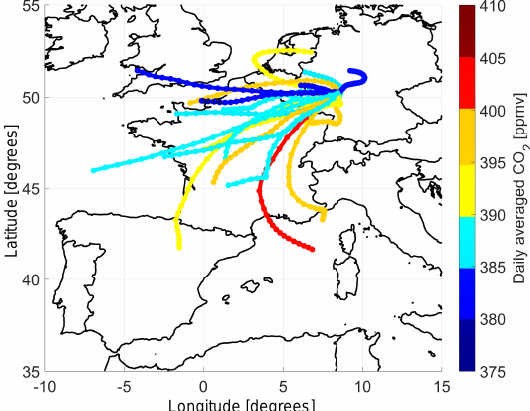
Figure 2. Daily averaged CO 2 observations and the associated stan- dard deviation during the measurement campaign parade on the Mount Kleiner Feldberg. The shaded areas indicate periods of high- pressure influence (white) and low-pressure influence (grey).